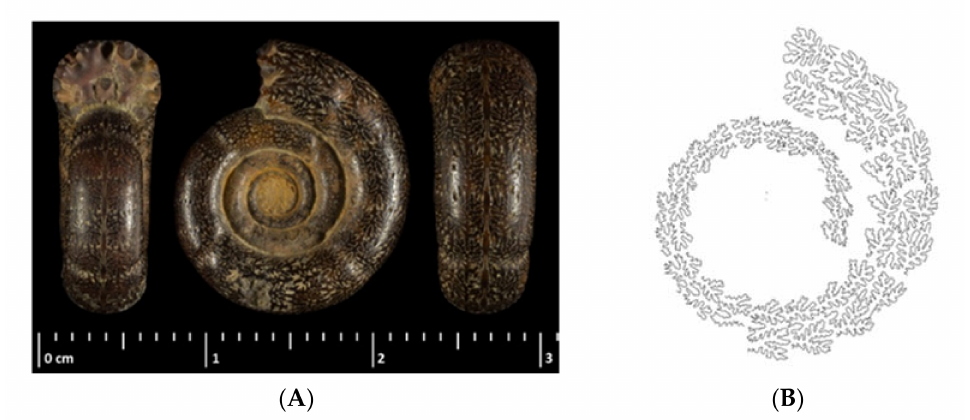
Figure 6. ( A ) Gaudryceras sacya Specimen MNHN-F-R00642 from Musee National d’Histoire Naturelle, Paris. ( B ) A tracing of MNHN-F-R00642 using only lateral lobe and saddle elements. Drawn by